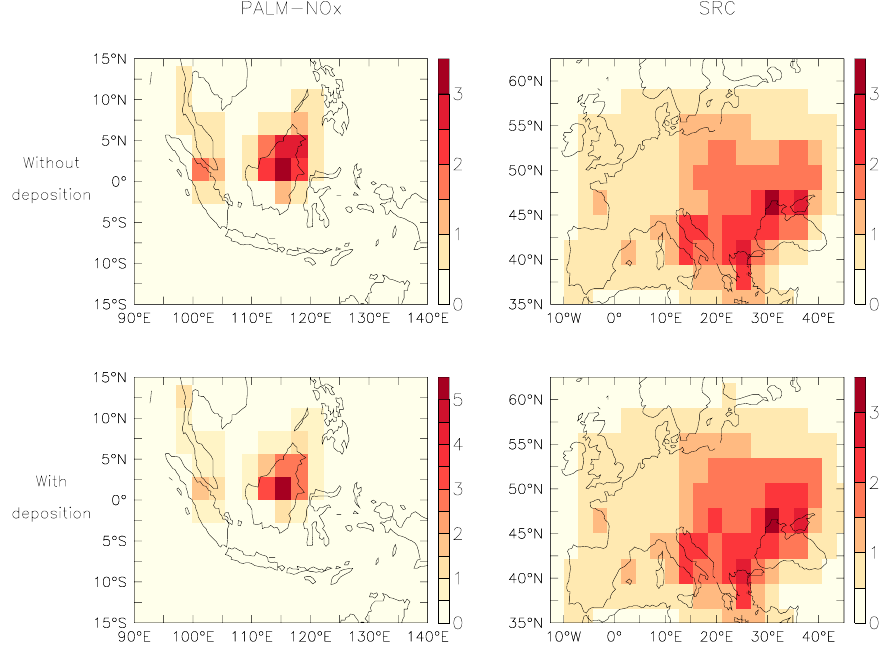
Fig. 6. Differences in annual mean surface ozone concentrations for PALM NO x vs. CTRL. (left) and SRC vs. CTRL (right) without changes in dry deposition (top) and with changes in dry deposition